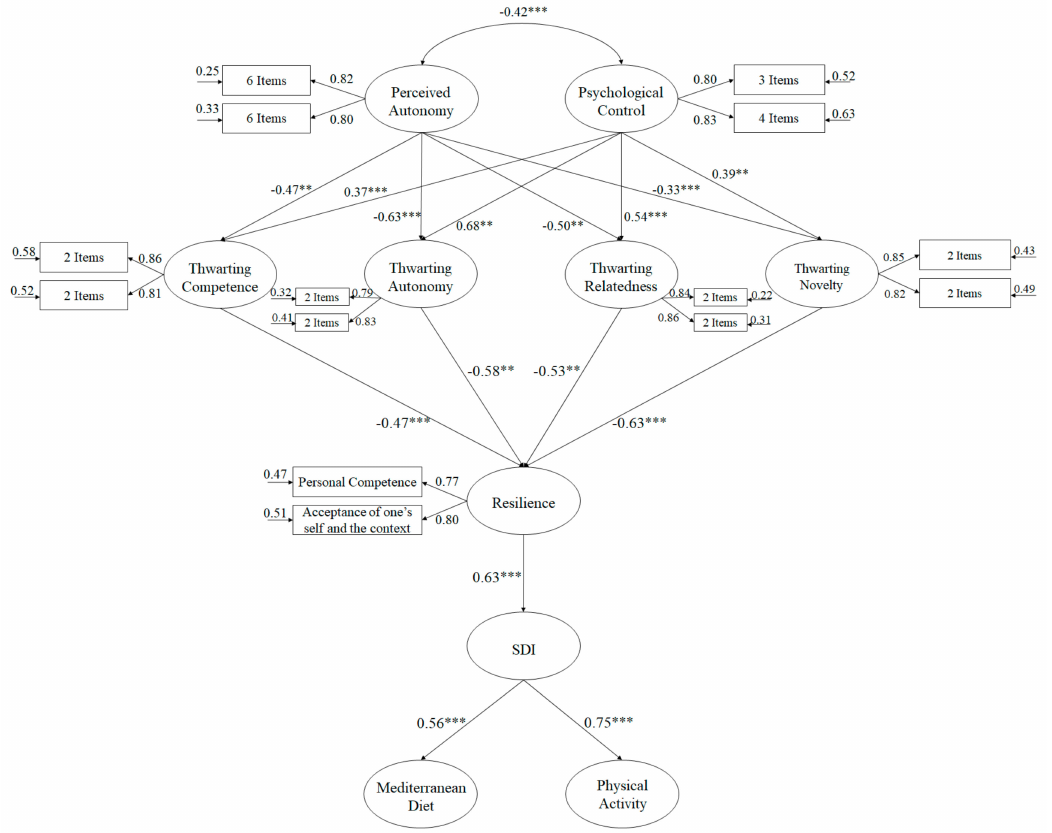
Figure 1. Hypothesized model, analizado a trav é s de un SEM. All parameters are statistically